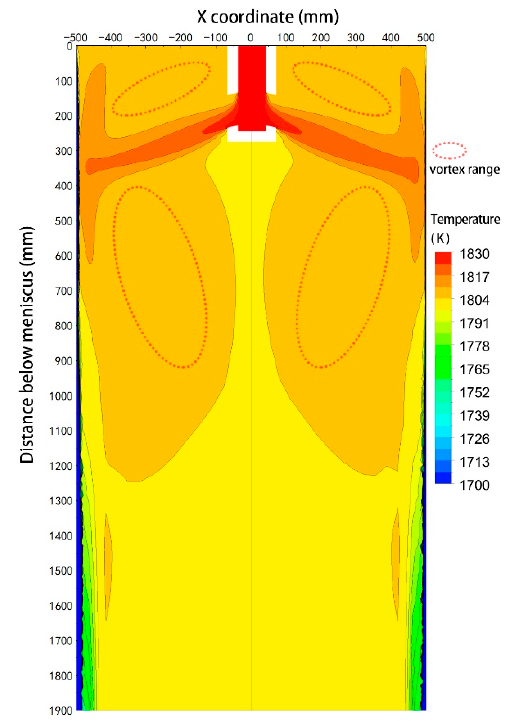
Figure 8. The contour of temperature in the Y = 0 plane.